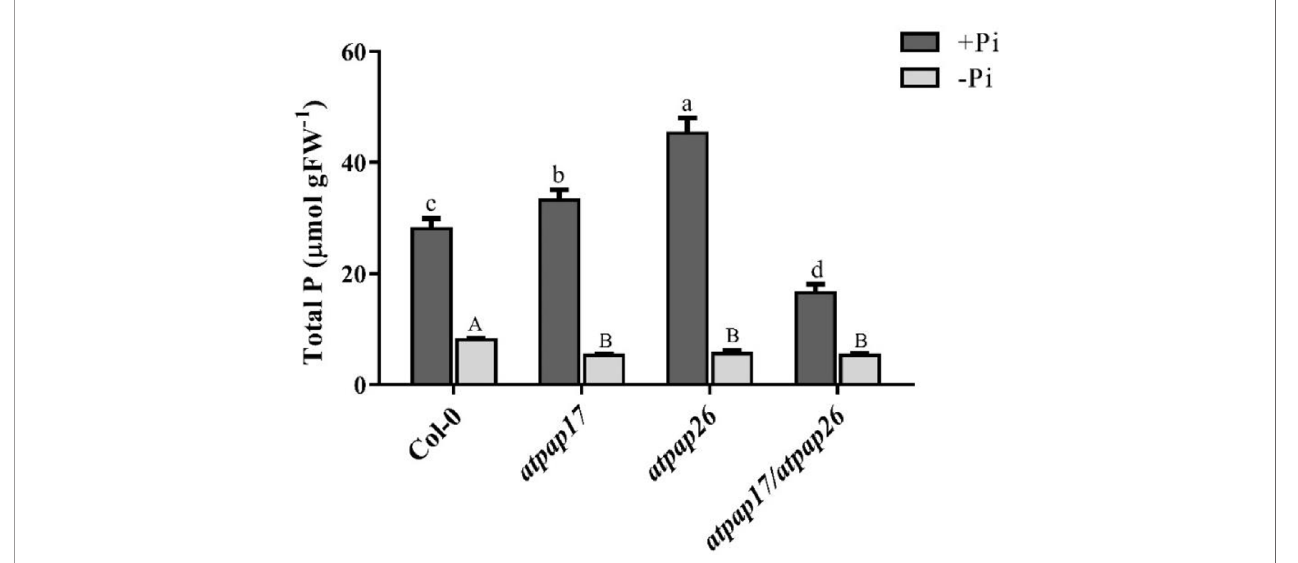
FIGURE 4 | Total P content of 21-day-old Arabidopsis seedlings of Col-0, AtPAP17 and AtPAP26 mutants ( atpap17 , atpap26 , and atpap17/atpap26 ) grown under +Pi (1.25 mM KH 2 PO 4 ) and − Pi (no Pi) conditions. Values are the means ± SE of three biological replicates. Signi fi cant differences are indicated by different letters above the bars ( P <